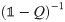
Eigenmode analysis of input-output relations.A Eigenvalue spectrum of the linearized model of Brunel [6]. The exceptional eigenvalue is shown in red, the bulk spectrum in green. B Eigenvalues of the close to 80000-dimensional linear system. Blue and green dots indicate the exceptional and bulk eigenvalues of W, respectively. Crosses mark eigenvalues of Q. C Eigenvalues of the matrix (1−Q)−1. D The eight output modes of the Q system. Shown are the change in output rate for each single neuron, due to each mode. Inset: Input perturbation decomposed into the eight modes, which are also the right eigenvectors of Q.